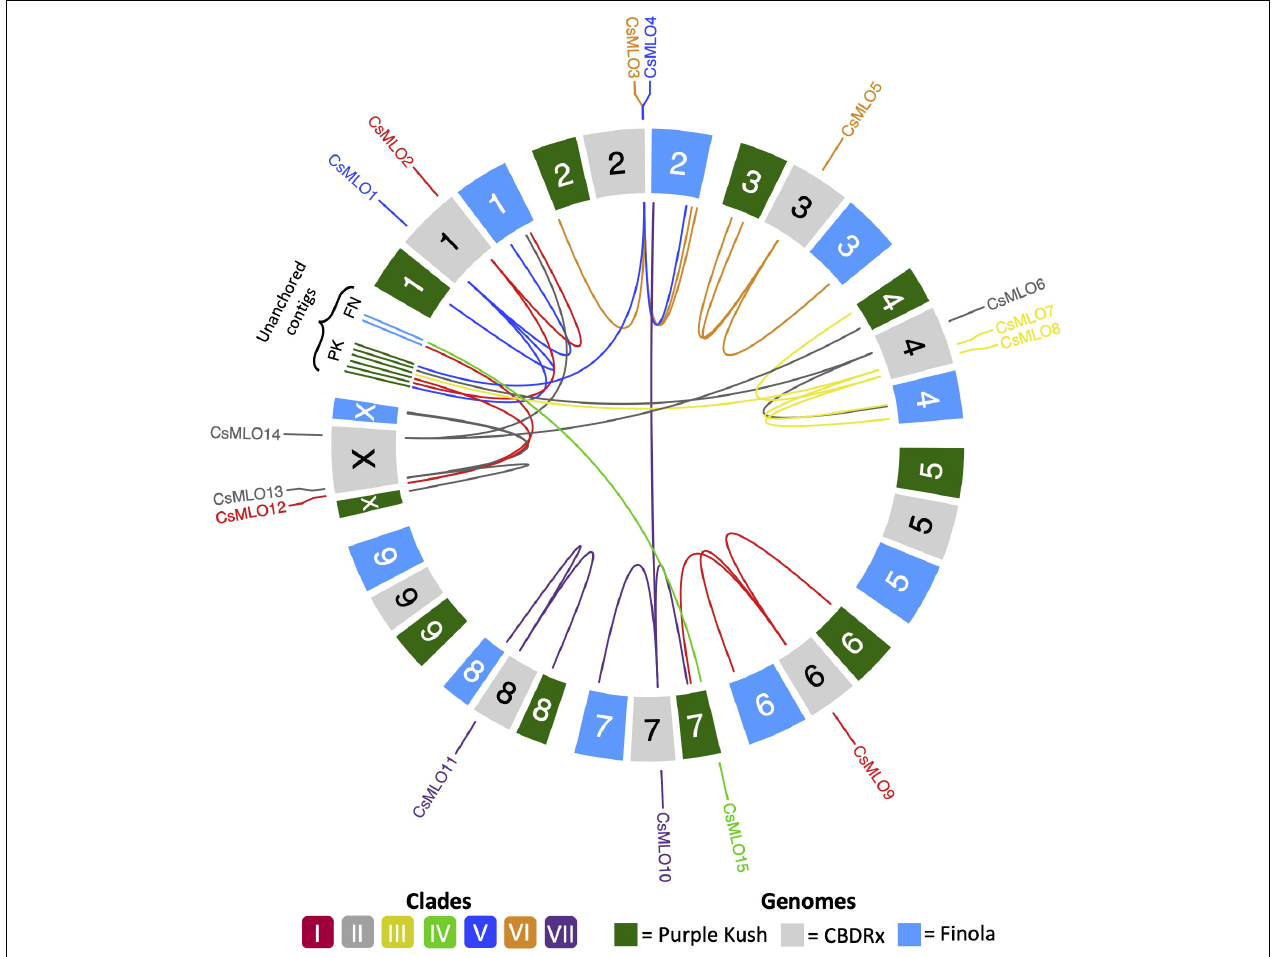
FIGURE 1 | Circular map of CsMLO genes identified in the chromosome-level assemblies of CBDRx, Finola, and Purple Kush. All 10 haploid chromosomes (9 autosomes + X chromosome) from each genome are displayed as colored boxes labeled with their respective chromosome number. Homologous chromosomes are grouped together, while unanchored contigs are located between chromosome 1 and chromosome X, grouped per genome. Chromosome numbers represent the “standardized” chromosome numbers, according to whole genome alignments with the CBDRx reference. Color indicate MLO clades, from I to VII. Homology relationships between the three genomes are displayed with solid lines of colors corresponding to each MLO clade. Clade IV CsMLO (herein named CsMLO15 ) is absent from the CBDRx